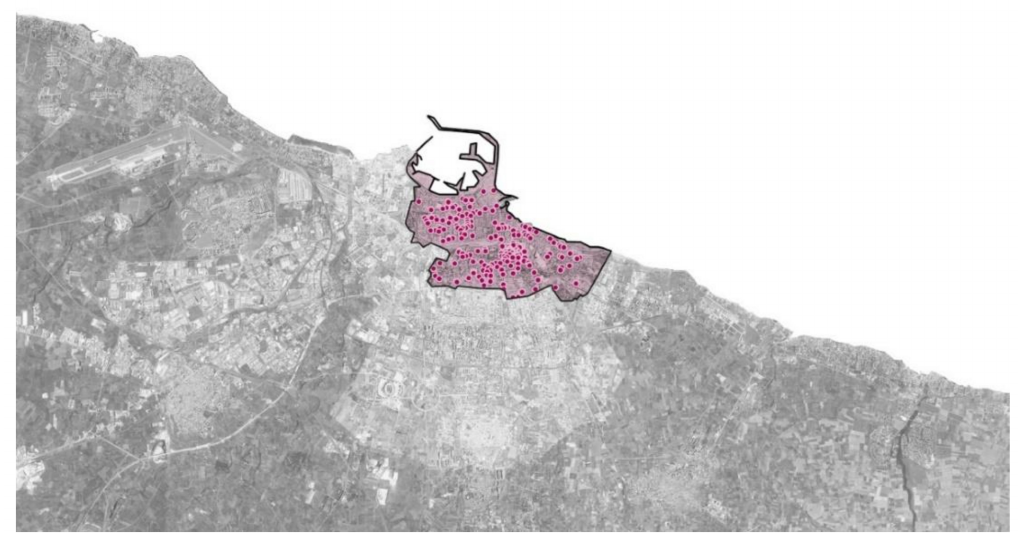
Figure 1. Localization of the study sample properties in the OMI central area of the city of Bari.